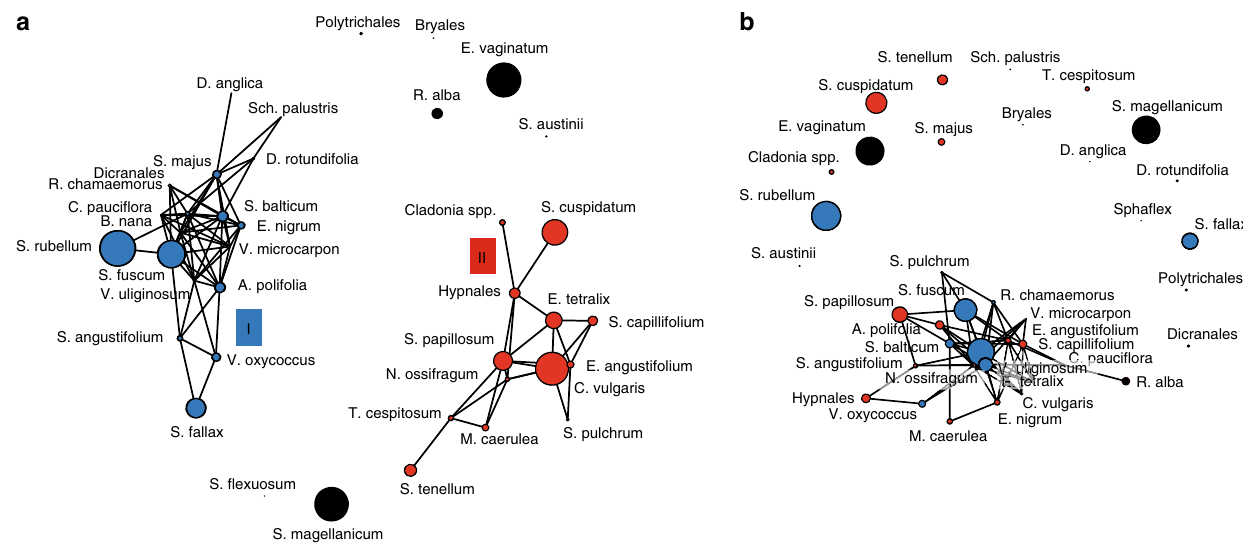
Fig. 3 Co-response clusters representing species similar in abundance-environment relationships. a Positive species interactions. b Negative species interactions. Colours represent two distinct co-response clusters (blue = I; red = II), while non-connected (black) points represent cluster-unrelated species. Black lines indicate correlations between species with a correlation coef fi cient ≥ 0.6. Circle size indicates the averaged abundance of species among all sites. See Supplementary Table 3 for full taxonomic